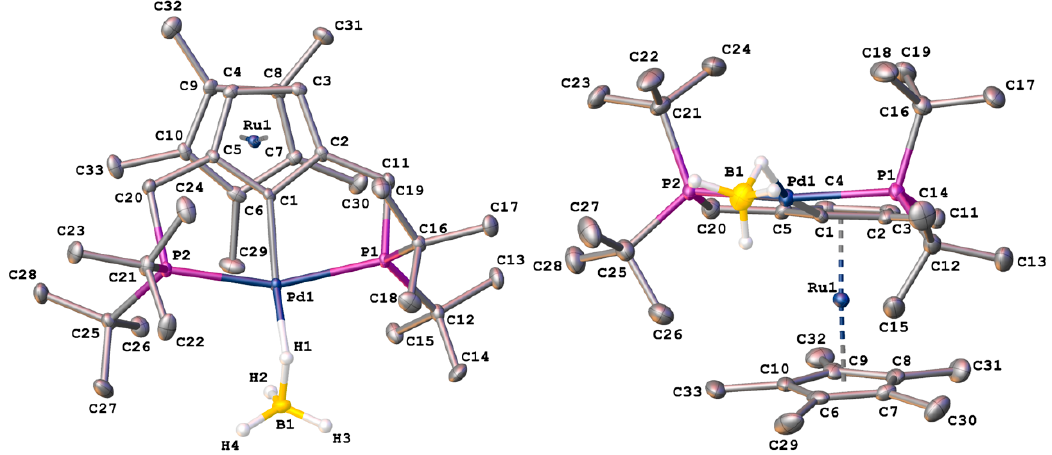
Figure 2. Two views of the compound 3b in representation of atoms via thermal ellipsoids at 50% probability level. Selected bond lengths (Å) and angles (°): Pd(1)–C(1) 1.990(5), Pd(1)–P(1) 2.3409(13), Pd(1)–P(2) 2.3453(13), Pd(1) ⋯ B(1) 2.560(7), Pd(1)–H(1) 1.82(5), Pd(1) ⋯ H(2) 2.34(6); C(1)–Pd(1)–H(1)